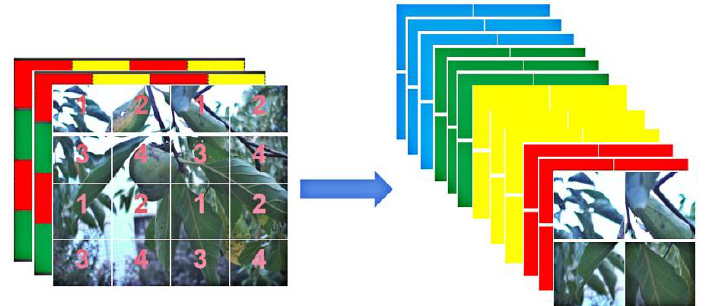
Figure 6. Flow chart of the slice operation.